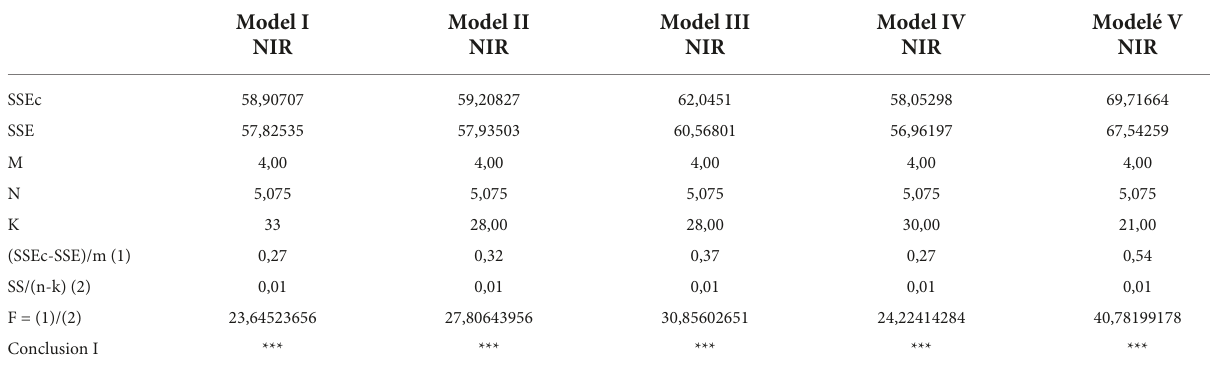
TABLE 11 Fisher statistics for the legal status.